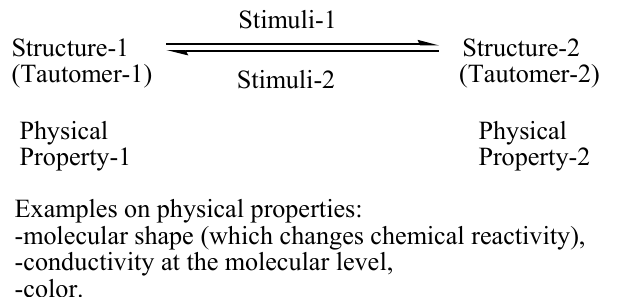
Molecules 2017 , 22 , 720;